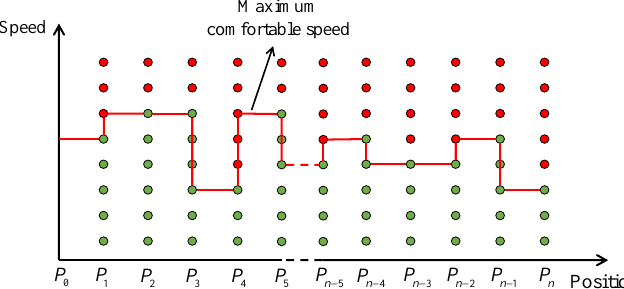
Figure 3. Schematic diagram of MCS